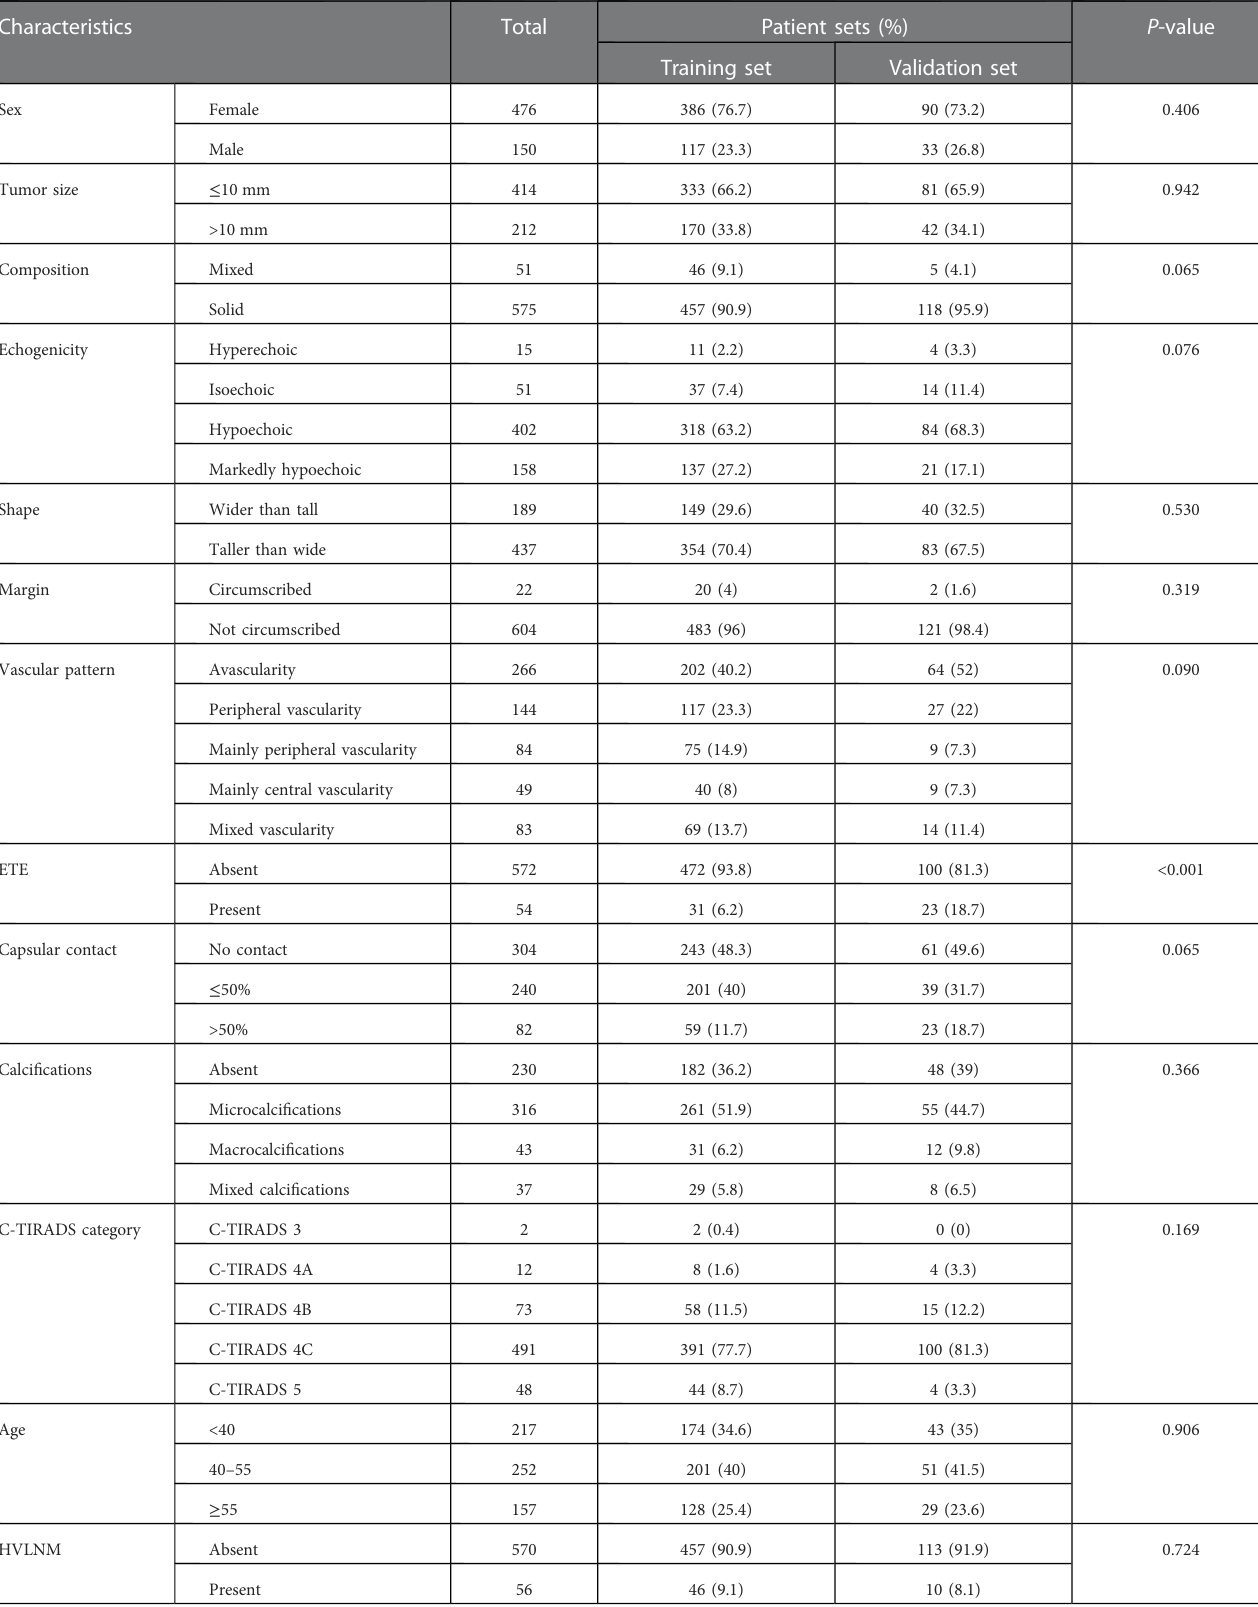
TABLE 1 Baseline demographic and ultrasonographic characteristics of patients with solitary